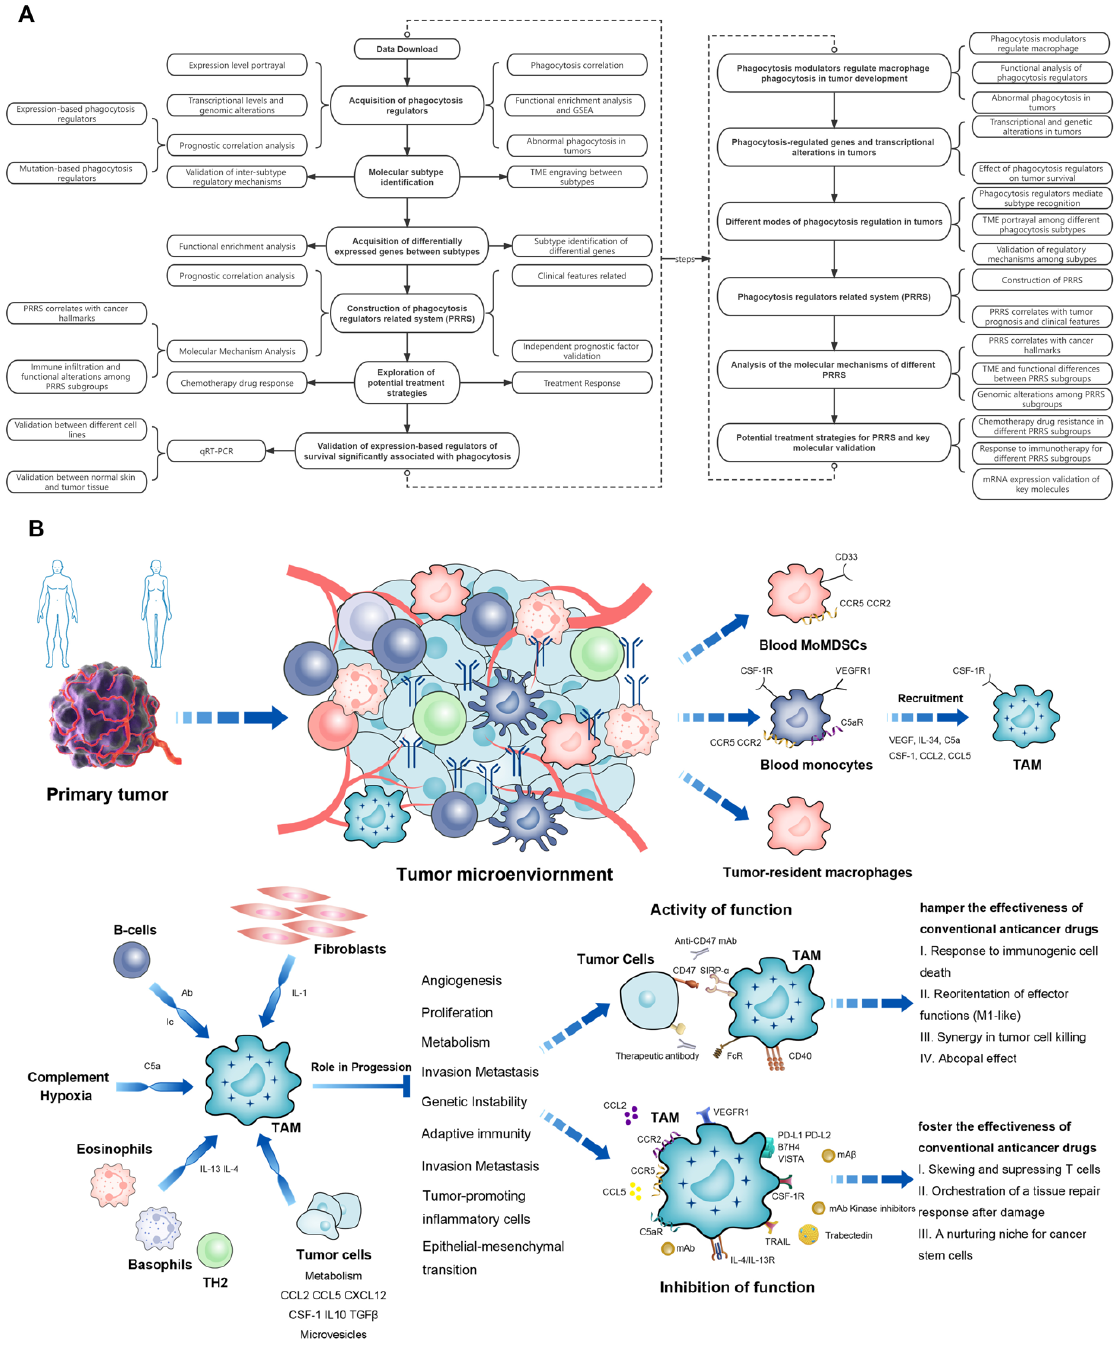
Figure 1. ( A ) The flowchart of this study and ( B ) a schematic diagram of the role of tumor-associated phagocytes (TAMs). TAMs are infiltrating tumor tissue macrophages, and are mainly differentiated from monocytes. Chemokines such as CSF1 and CCL2 secreted by tumor cells can recruit monocytes from peripheral circulating blood to the tumor microenvironment (TME), after which monocytes differentiate into macrophages. TAMs are an essential component of the TME, and are often associated with poor prognosis and drug resistance; they have emerged as very promising targets in cancer immunotherapy.